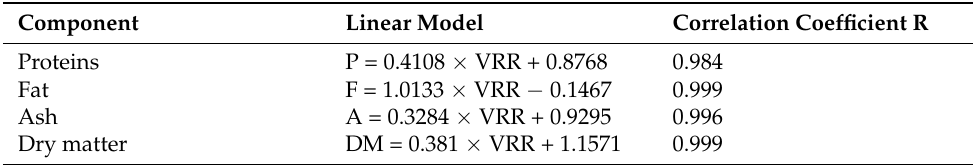
Table 3. Linear models for concentration factor of buttermilk compounds depending on the volume reduction ratio.